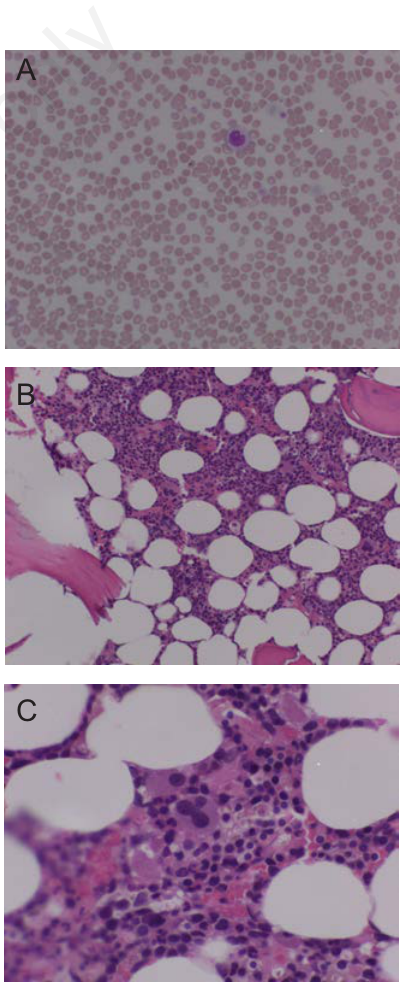
Figure 1. A) Peripheral smear showing slight anisocytosis, monocytosis with marked thrombocytopenia with some giant platelets; B, C) Bone marrow biopsy showing granulopoiesis, hypercellular marrow with increased myelomonocytic cells and megakaryocytogenesis at lower (B) and higher (C)